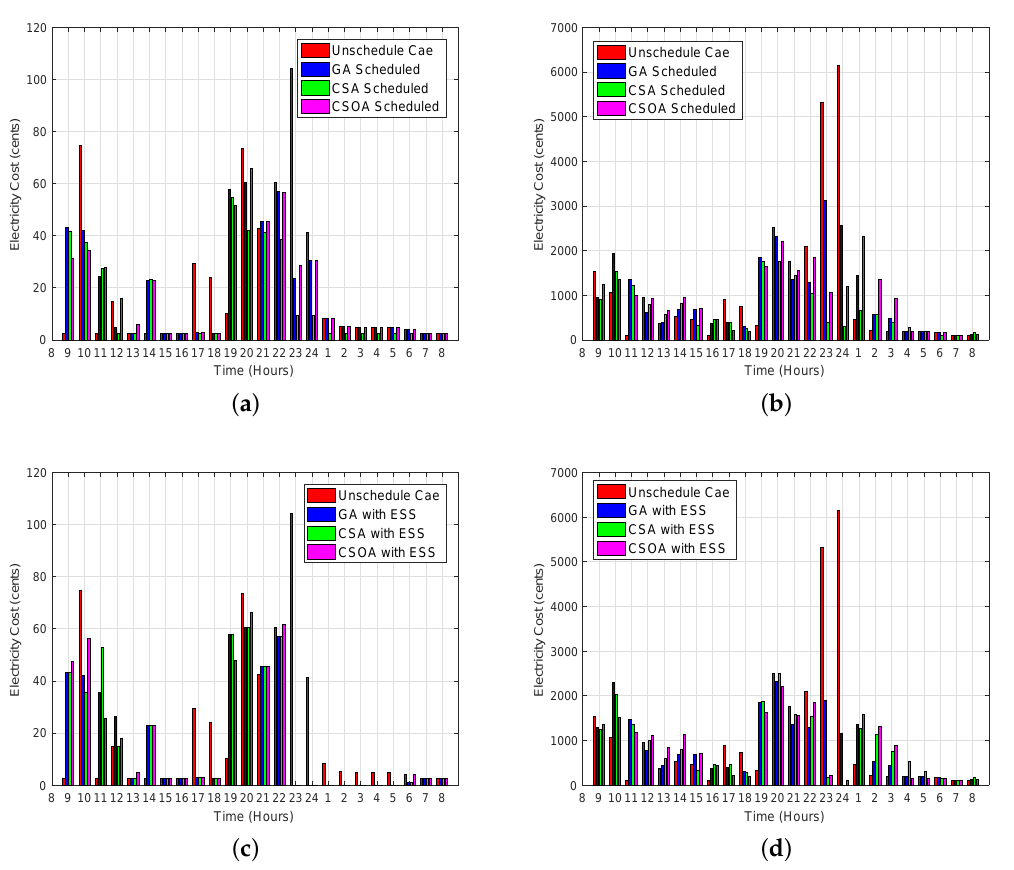
Figure 9. Hourly electricity cost using RTP signals. ( a ) Hourly electricity cost for a single smart home without ESS; ( b ) hourly electricity cost for 30 smart homes without ESS; ( c ) hourly electricity cost with ESS for a single smart home; ( d ) hourly electricity cost with ESS for 30 smart